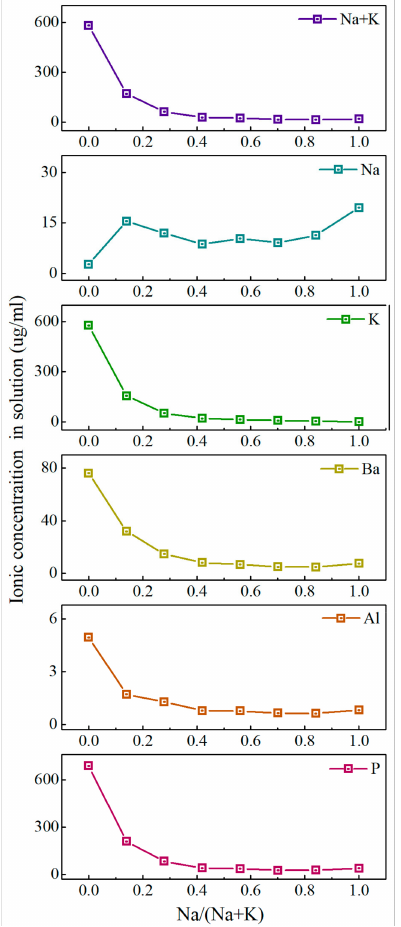
Figure 4. Ionic release concentration in solution of the PKNi glass with different Na/Na+K ratios in a 90 ◦ C water bath for 48